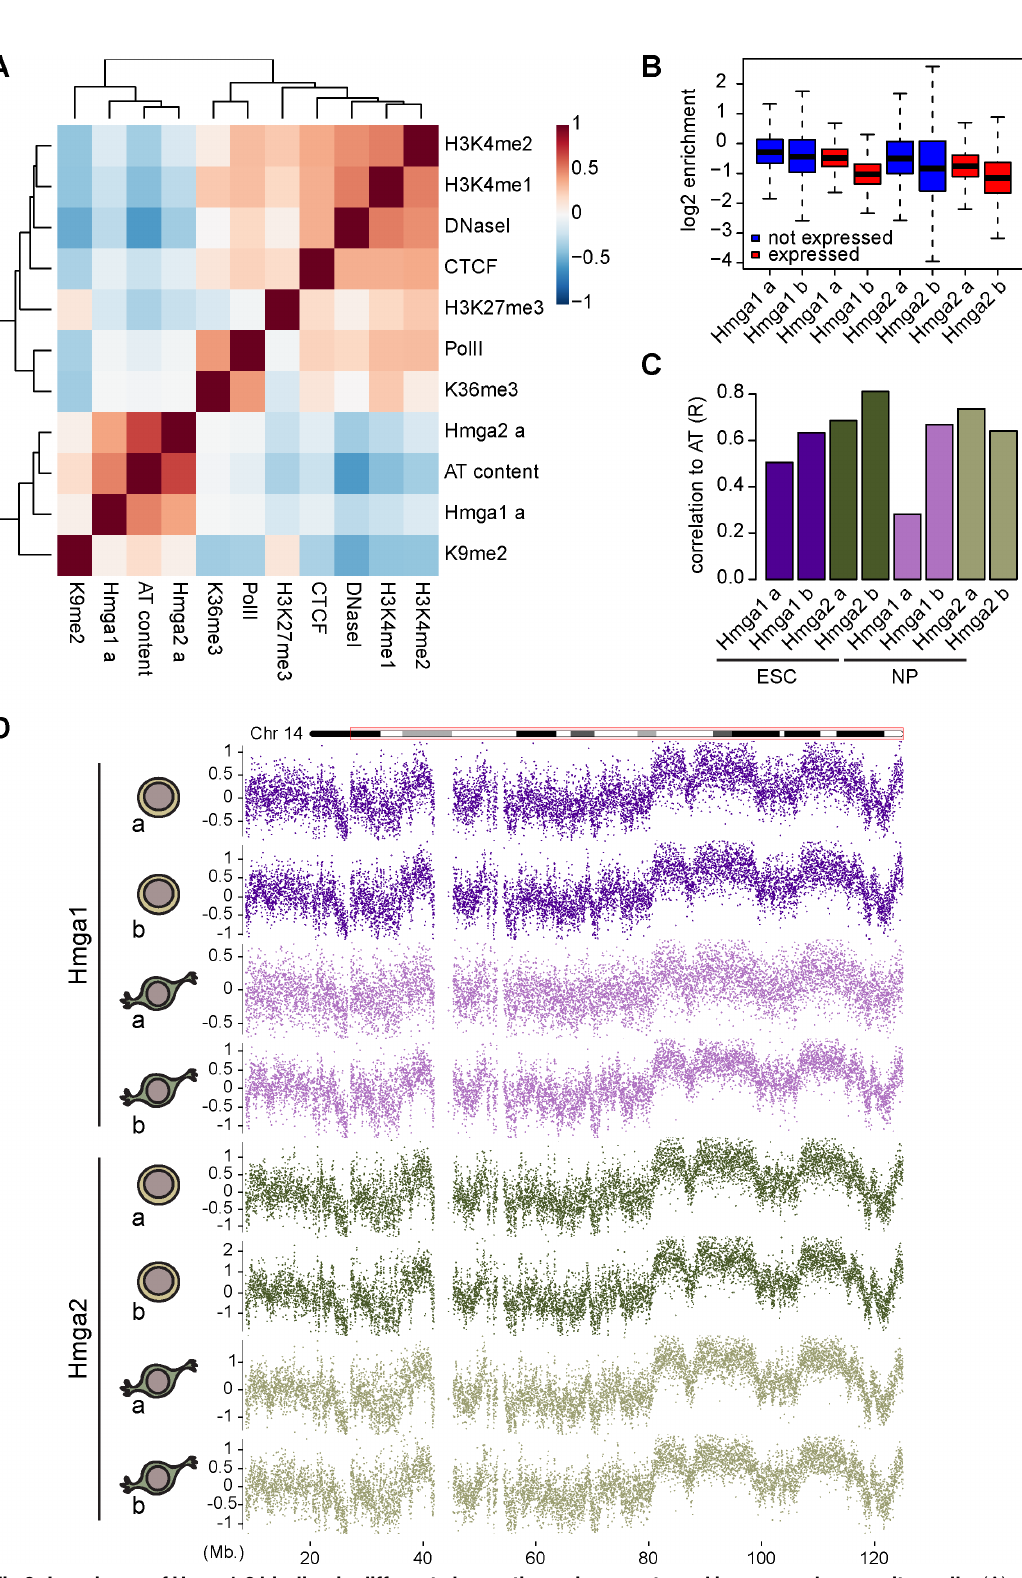
PLOS Genetics | https://doi.org/10.1371/journal.pgen.1007102 December 21,